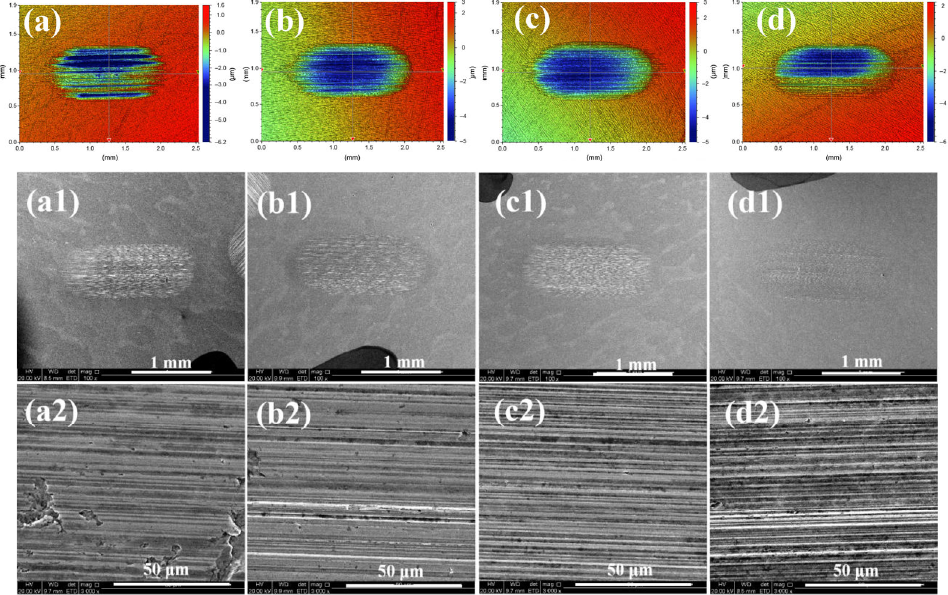
Fig. 5 Three-dimensional contours of the lubricating materials: (a) BTA-P 4444 , (b) 1% BTA-P 4444 -Lig, (c) 3% BTA-P 4444 -Lig, and (d) 5% BTA-P 4444 -Lig lubricating materials; (a1–d1) full views of the wear spots under the SEM at 100-time magnification; and (a2–d2) surface morphologies of the wear spots observed under the SEM at 3,000-time magnification.